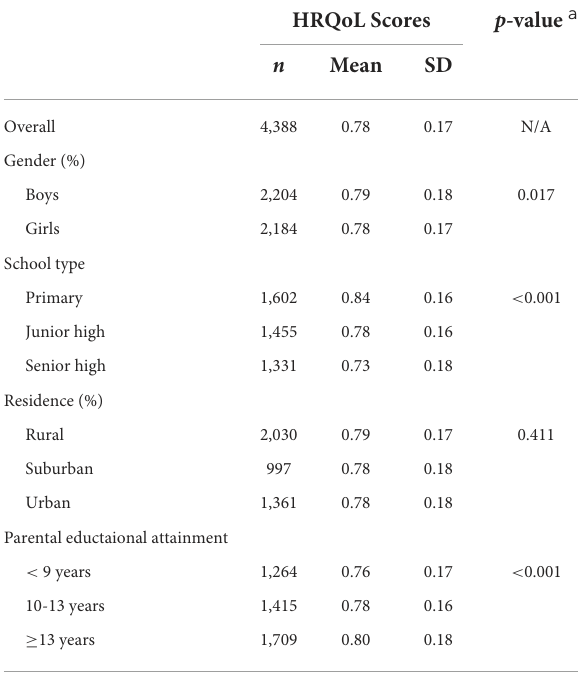
TABLE 2 HRQoL scores based on CHU9D among participants by selected characteristics in this